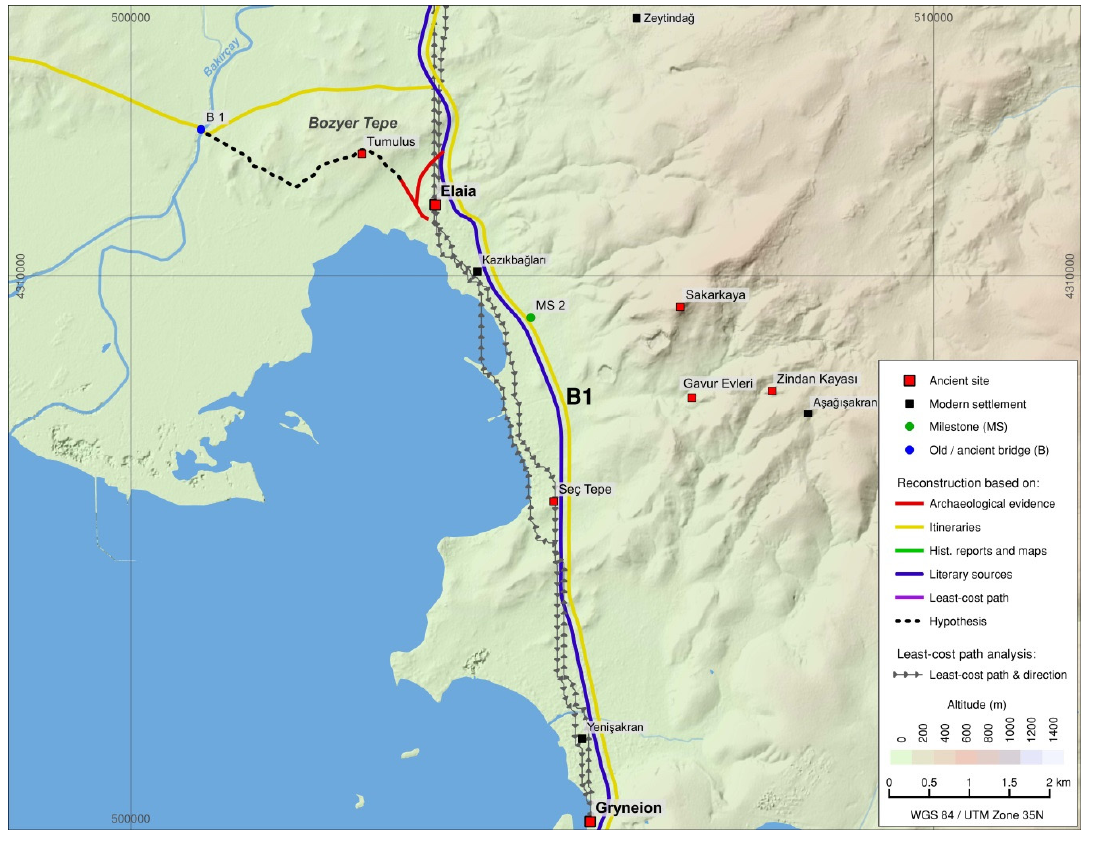
Figure 9. Calculated least-cost paths and reconstructed route between Gryneion and Elaia.